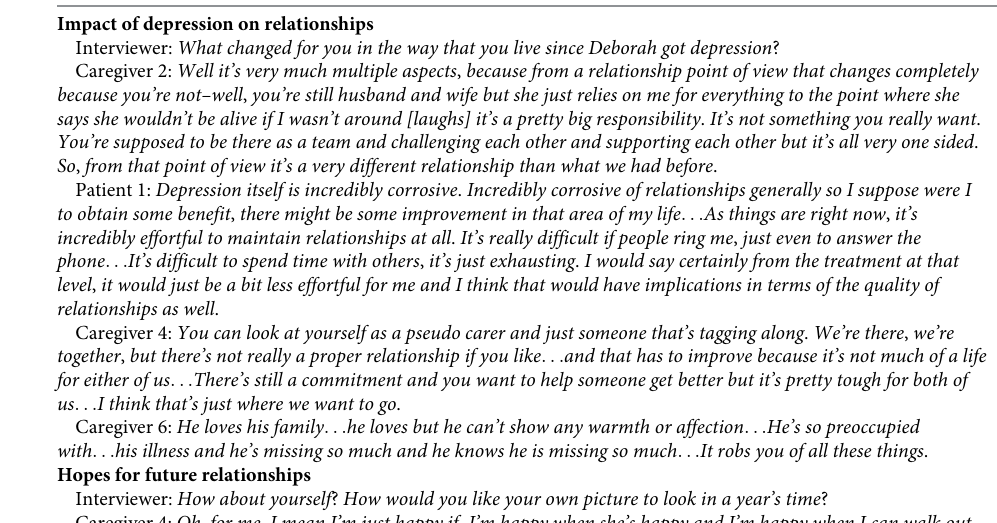
Table 5. Relationships and